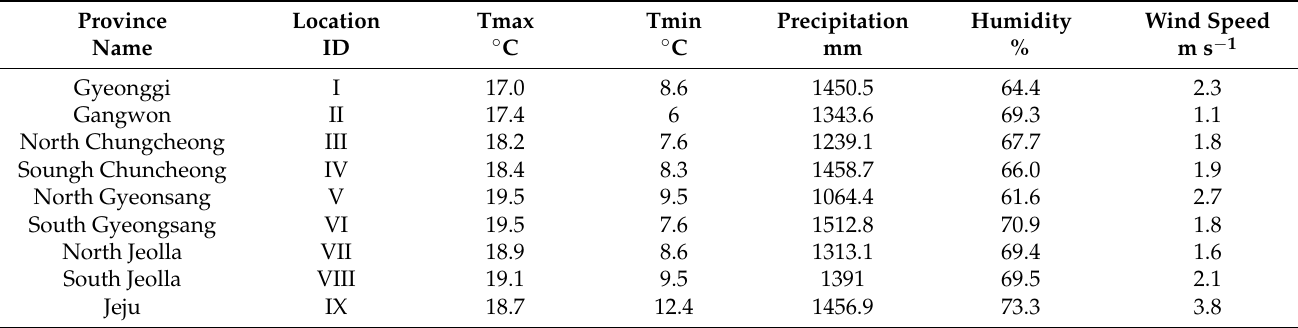
Table 1. Mean annual maximum and minimum temperature, total precipitation, humidity, and wind speed during 1989–2010 in the nine provinces of South Korea [20].